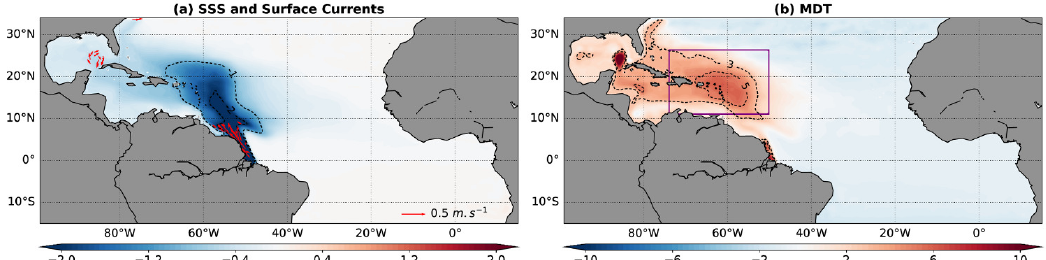
Figure 5. Amazon runoff contribution to the mean-state of oceanic surface variables: ( a ) SSS (PSU, color) and surface currents (m · s − 1 , arrows) and ( b ) Mean Dynamic Topography (cm). The purple rectangle is the box used to compute area averaged diagnostics. Averages have been performed over the period